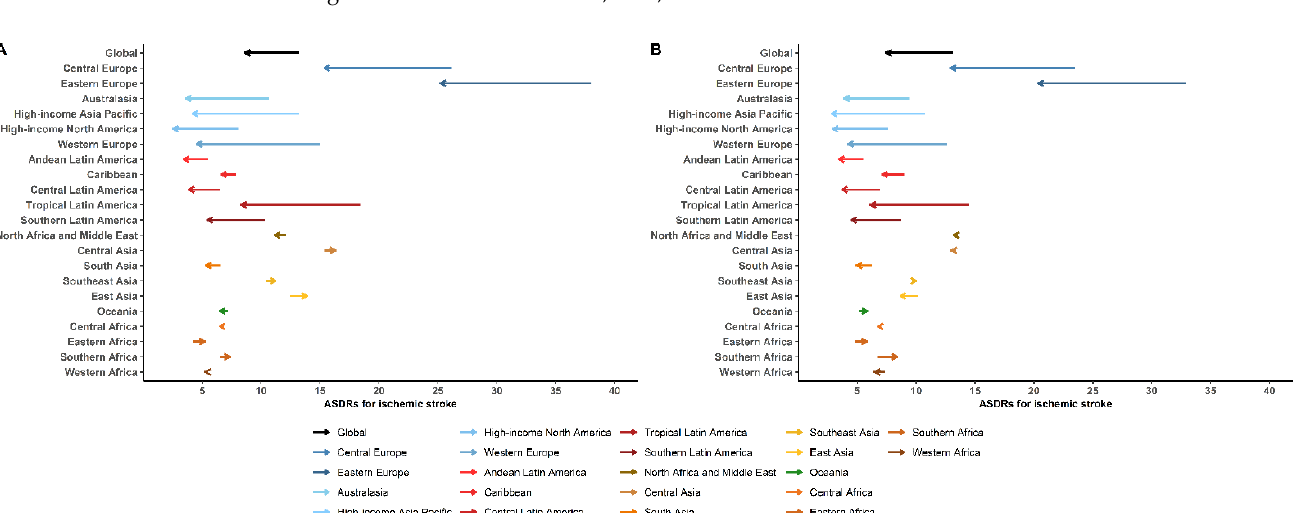
Figure 4. Change in age-standardized death rates per 100,000 of the general population from ischemic heart disease attributable to high low-density lipoprotein cholesterol between 1990 and 2019 by region for men ( A ) and women ( B ). Data obtained from the GBD database available on https://vizhub.healthdata.org/gbd-results/ (accessed on 1 July 2022) [14]. Abbreviations: ASDRs, age-standardized death rates; IHD, ischemic heart disease.